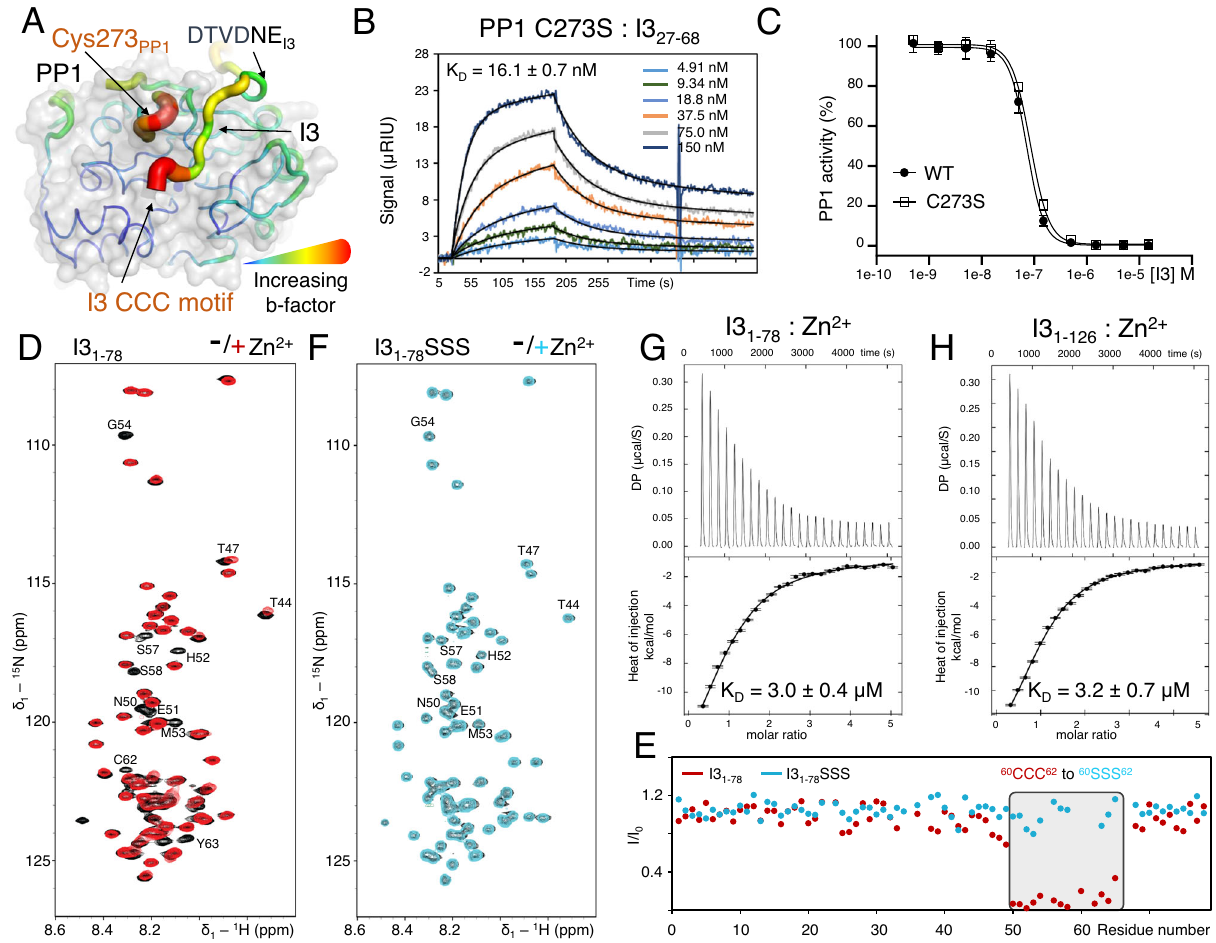
Fig. 4 | The I3 CCC motif – PP1 active site interaction. A Structure of the I3:PP1 complex. PP1 and I3 are shown as a pymol sausage plot to re fl ect relative B factor values (thin blue lines, lowest B factors; fat red lines, highest B factors). PP1 trans- parent surface also shown in gray. B SPR sensorgram between I3 27-68 and PP1 α 7-330 C273S. C IC 50 data for I3 27-68 with PP1 α 7-330 C273S and WT. Data are presented as mean values±SD, n =8 technical replicates. D 2D [ 1 H, 15 N] HSQC spectrum of 15 N-labeled I3 1-78 alone (black) and after the addition of a 4-fold molar excess of Zn 2 SO 4 (red). E Peak intensity loss vs I3 protein sequence plot upon addition of